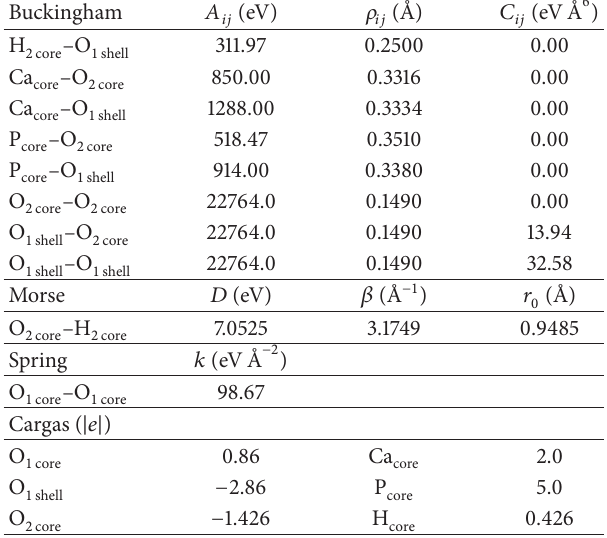
Table 1: Interatomic potentials parameters for